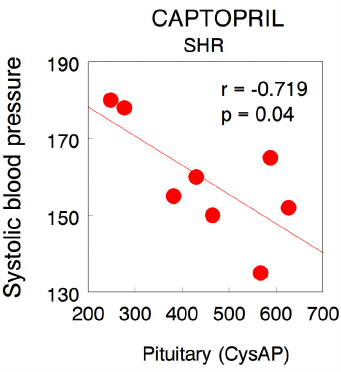
Figure 6. Level of correlation between systolic blood pressure (mmHg) and CysAP activity (nmol/min/mg of proteins) in the pituitary of captopril-treated spontaneously hypertensive rats.